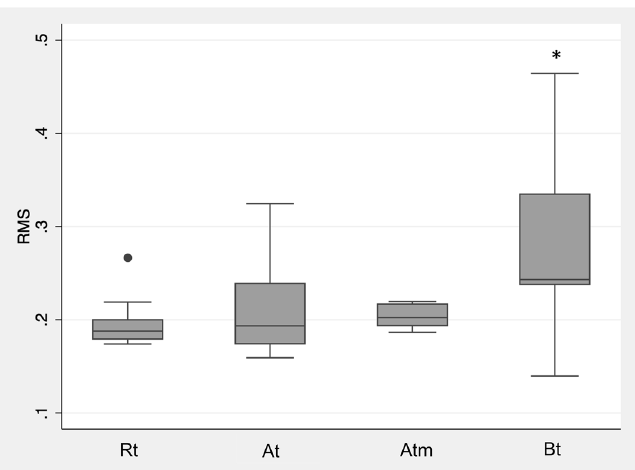
Figure 9. Root Mean Square (RMS) values of extrusion-based surgical guides (Rt, At, Atm, Bt) after thermal annealing and steam sterilization. Bt showed significant differences (*p < 0.05) to the other evaluated groups.